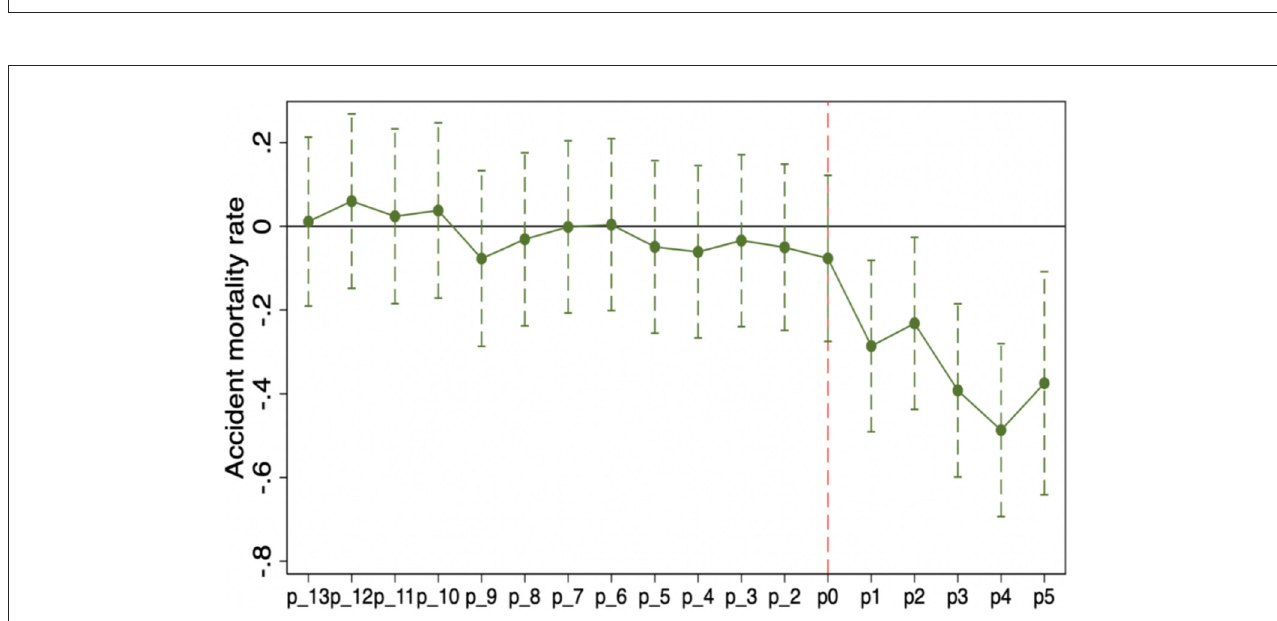
FIGURE3 The result of dynamic effects (Accident mortality